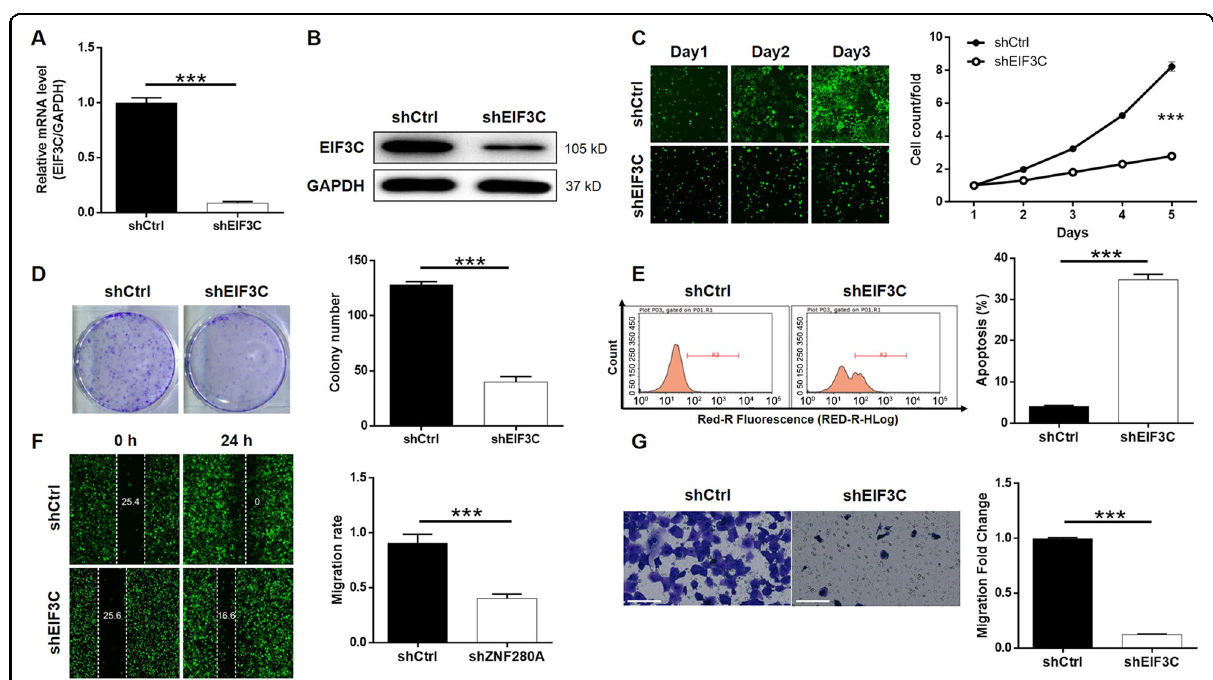
Fig. 5 EIF3C knockdown inhibited LUAD development in vitro. A , B Cell models with or without EIF3C knockdown were constructed. The knockdown ef fi ciency of EIF3C in NCI-H1299 cells was assessed by qPCR A and western blotting B , respectively. C Celigo cell counting assay was employed to show the effects of EIF3C on cell proliferation of NCI-H1299 cells. D Colony formation assay was used to evaluate the ability of NCI- H1299 cells with or without EIF3C knockdown to form colonies. E Flow cytometry was performed to detect cell apoptosis of NCI-H1299 cells with or without EIF3C knockdown. F , G The effects of EIF3C on cell migration ability of NCI-H1299 cells were evaluated by wound-healing assay F and Transwell assay (Scale bar = 100 μ m) G . The representative images were selected from at least three independent experiments. Data were shown as mean ± SD. * P < 0.05, ** P < 0.01, *** P <